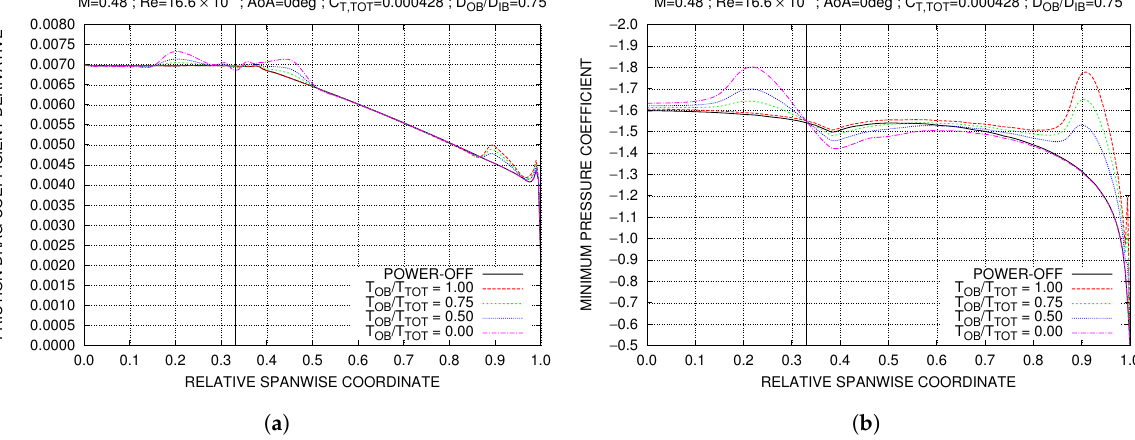
Figure 15. Wing spanwise loading with IB and OB propellers in cruise conditions at constant total thrust: ( a ) friction drag coefficient derivative; ( b ) minimum pressure coefficient. The propellers’ swirl effect is instead illustrated in Figure 18, where visualizations of local inflow angle of attack are provided on a surface located between the wing leading edge and propellers’ planes, at different thrust distributions. The impact of the OB propeller on the wing tip vortex is instead visible from Figure 19, where contour plots of stream-wise vorticity at zero angle of attack are included on several stations downstream of the wing for both power-off and one of the analyzed power-on conditions with both propellers operative, highlighting the reduction in vorticity peak at the wing